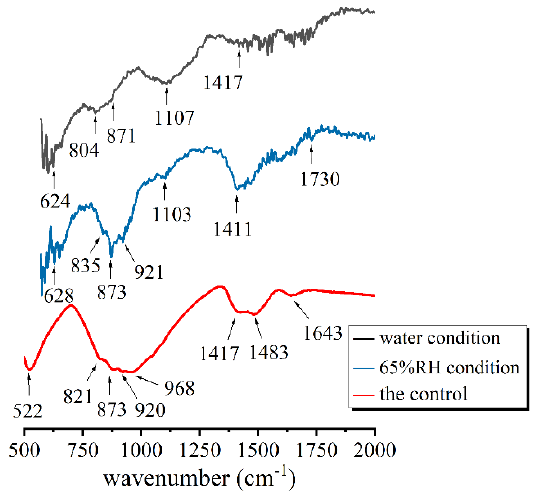
Figure 6. FT-IR spectra of hydration products under different hydration conditions.